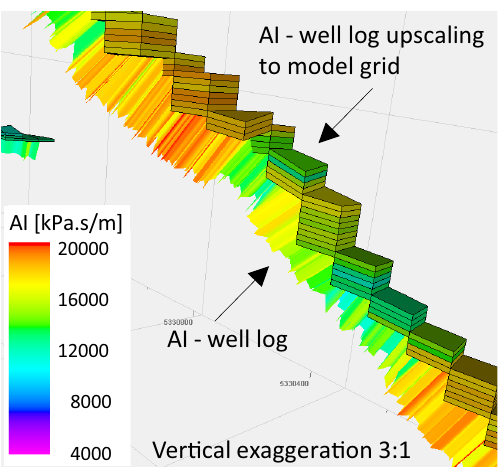
Fig. 7 The acoustic impedance logs (calculated from the sonic logs and the density logs during the seismic-well tie) were upscaled into the grid cells along the six well paths. The upscaled data was then used to create a vertical mean trend as an input parameter to generate a trend model as a starting point for the inversion algorithm